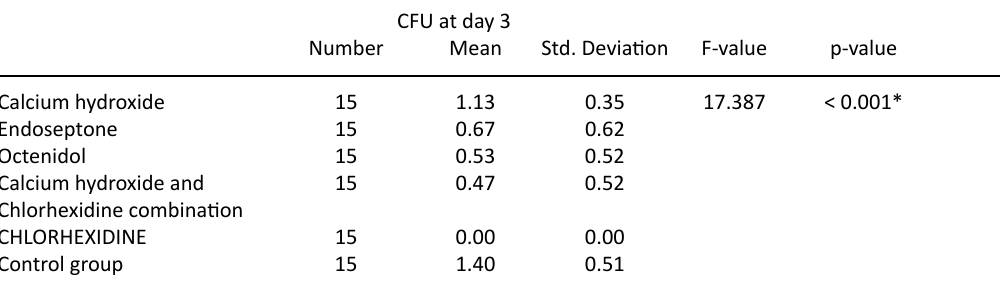
CFU at day 1 Mean Difference